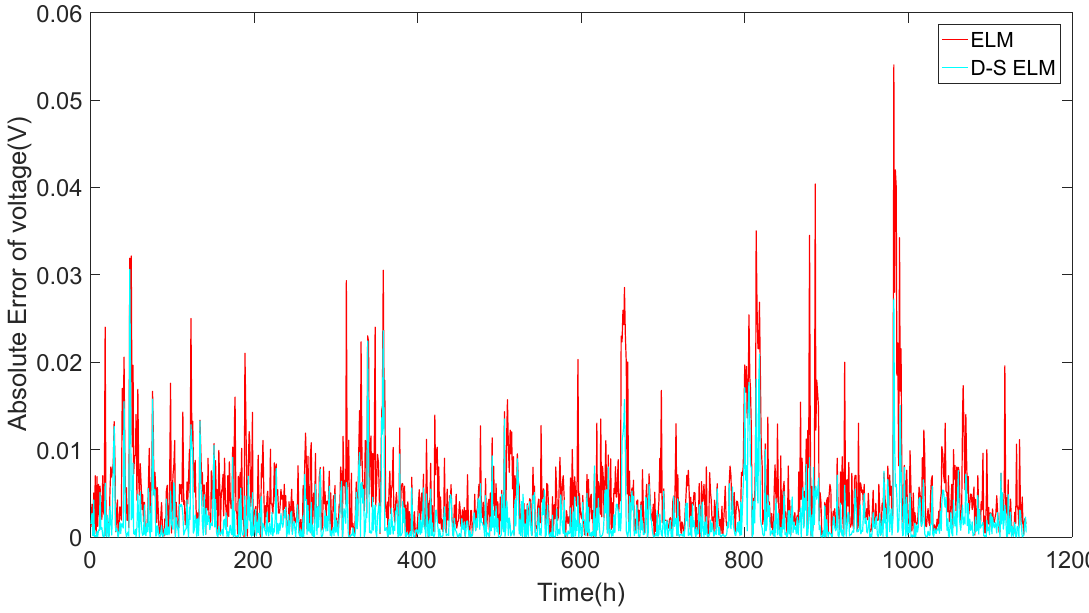
Figure 7. Error curves of ELM and D-S ELM (the size of training sample is set as 10).